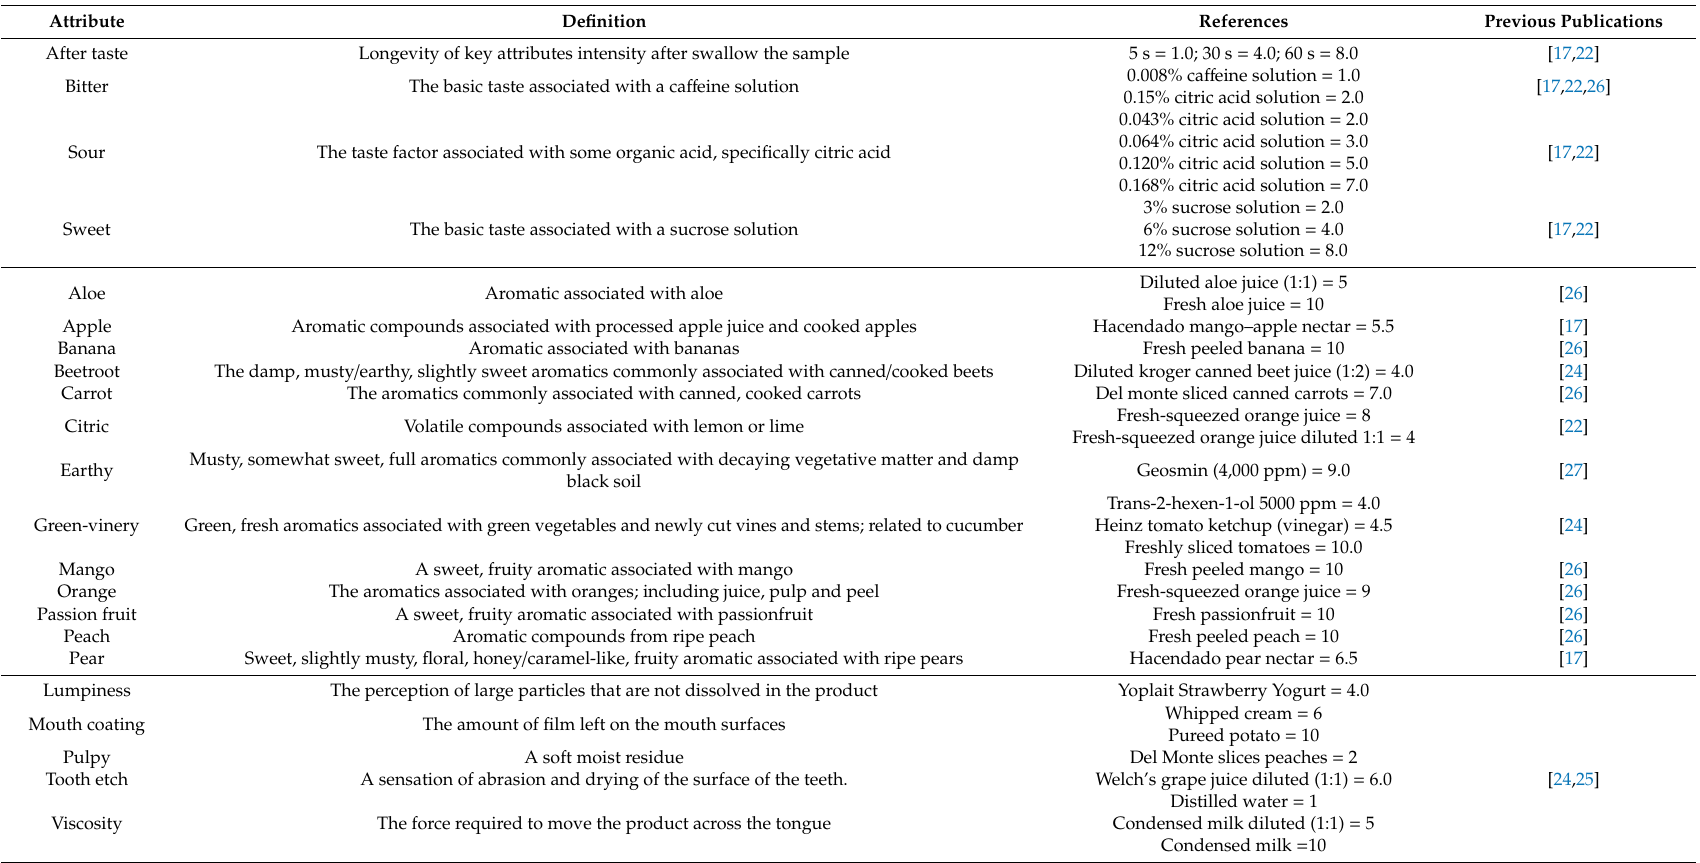
Table 2. Lexicon of the sensory